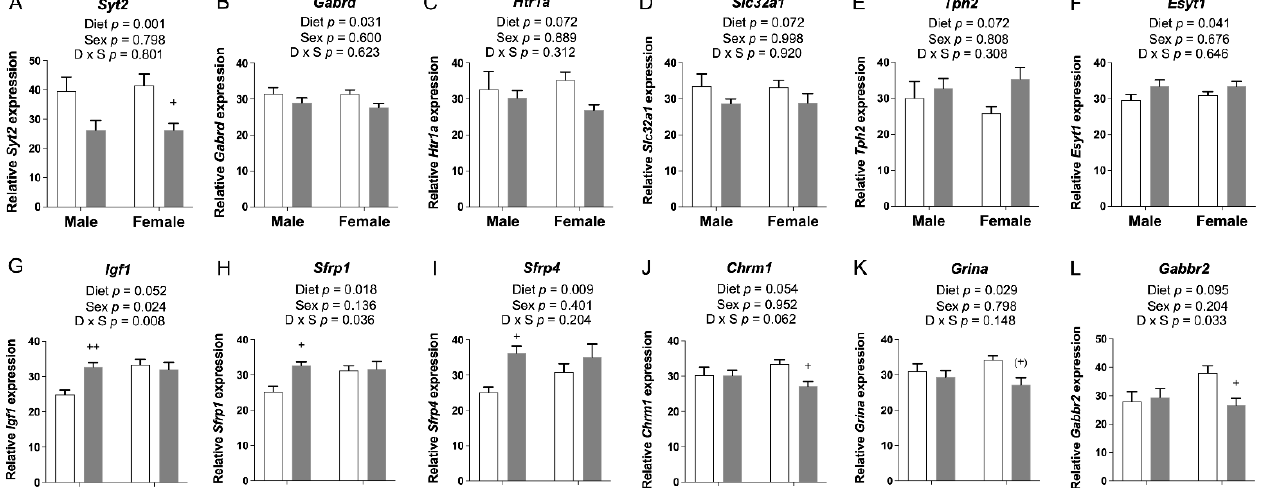
Figure 1. Hierarchical clustering showing different changes in P30 cortical gene expression due to maternal FASD in males and females. A total of 599 genes (357 downregulated, 242 upregulated) were differentially expressed in FASD males compared with CD males, and 419 genes (202 down- regulated, 217 upregulated) were differentially expressed in FASD females compared with CD fe- males.